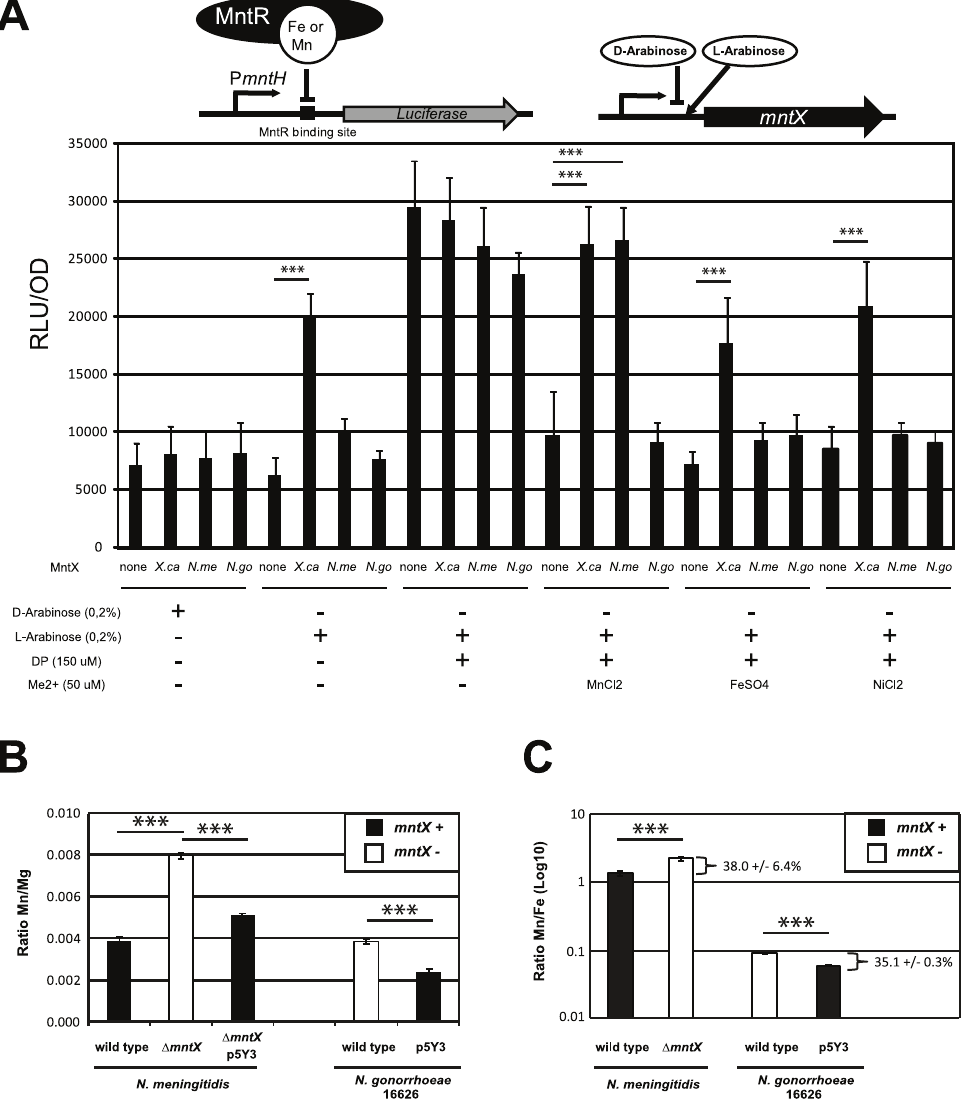
Figure 5. MntX is a manganese exporter. A ) MntX depletes E. coli intracellular metal pools. The E. coli K-12 strain D fur P mntH::luc emits light upon intracellular metal depletion with the divalent metal chelator 2,2 9 -Dipyridyl (DP). This process is suppressed by co-incubation of DP with divalent metals, therefore allowing monitoring potential metal export activity. Plasmid-driven expression of MntX was induced with L-arabinose. Each bar represents the average of four independent measurements and is representative of several experiments B and C ) ICP-MS quantification of divalent metals contents (Mg, Mn, and Fe), for strains of N. meningitidis and N. gonorrhoeae harboring mntX Nm (black bars) or not (white bars) and grown in rich medium. The data are expressed in ratio Mn/Mg in B and Mn/Fe in C. Each bar represents the average of three independent measurements for N. meningitidis and two for N. gonorrhoeae (*** p , 0.01).